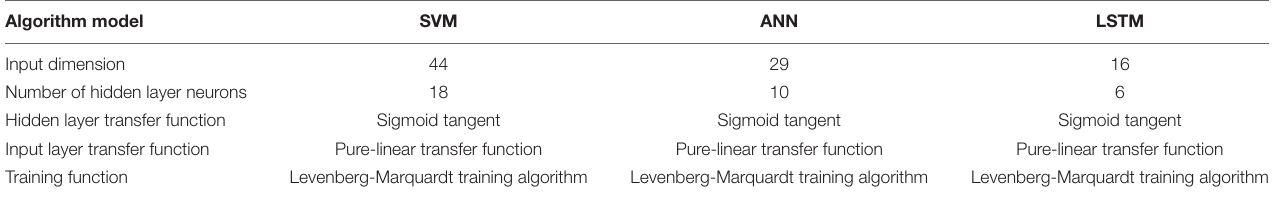
TABLE 2 | The main structural parameters of the prediction